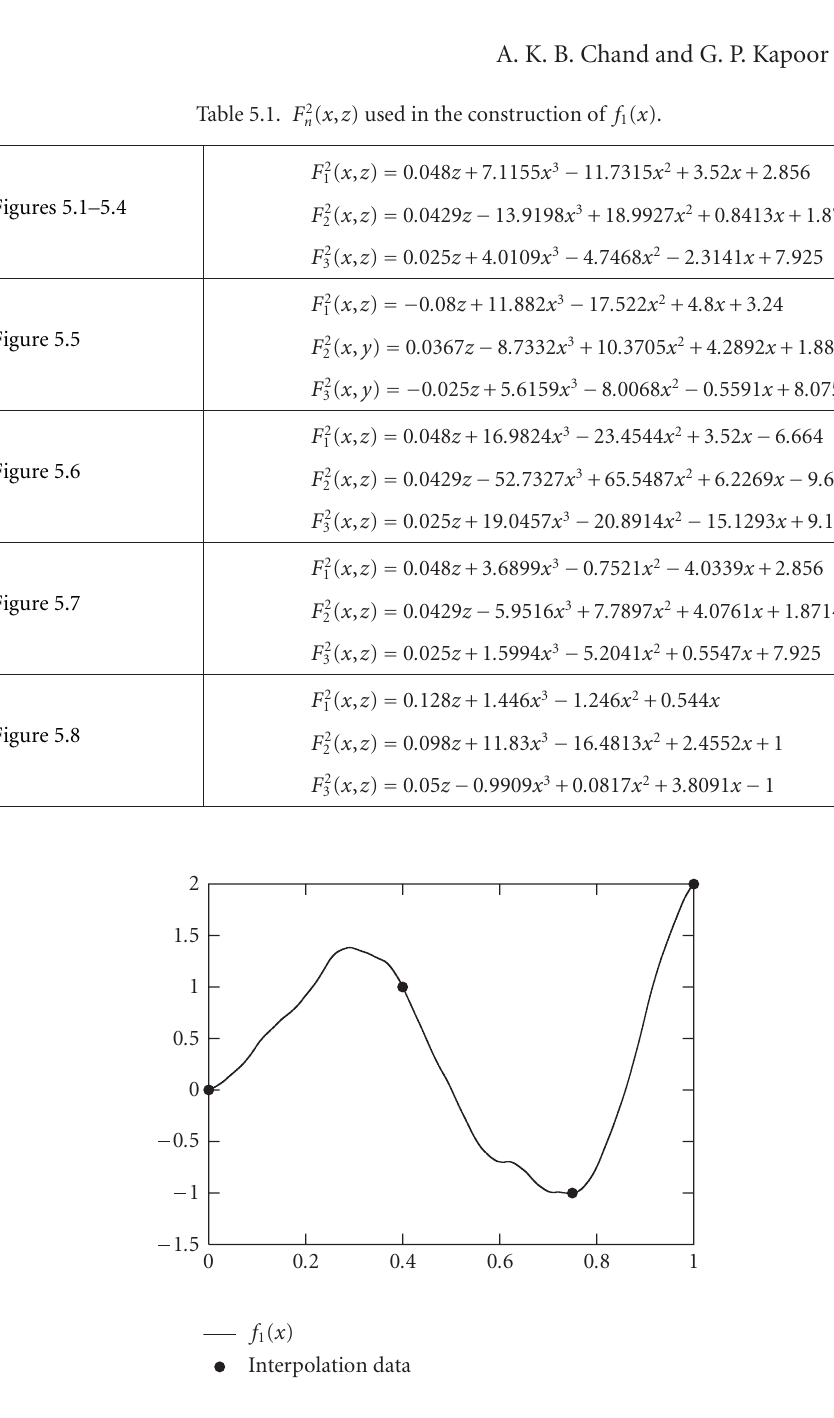
Figure 5.2. E ff ect on spline CHFIF by a change in boundary conditions of f 1 ( x